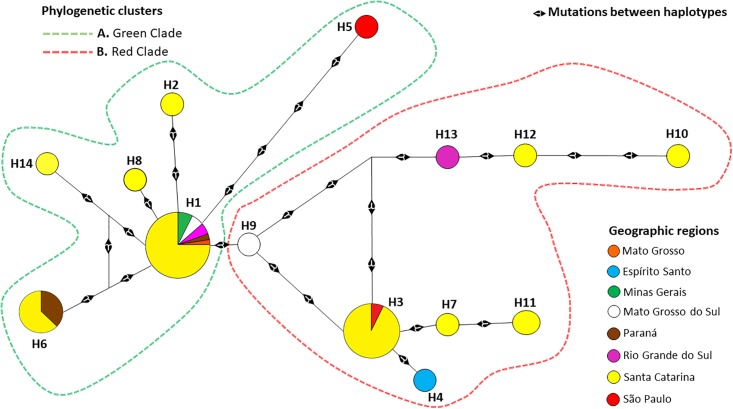
Genetic network of the 60 sequences of samples of apxIA gene in Brazil.The haplotypes are colored according to the geographical state in which the sample was collected. The size of the circle halo is proportional to the relative frequency or number of samples in the group of haplotypes. The black arrows indicate the number of mutations that differentiate one haplotype from the nearest haplotype.